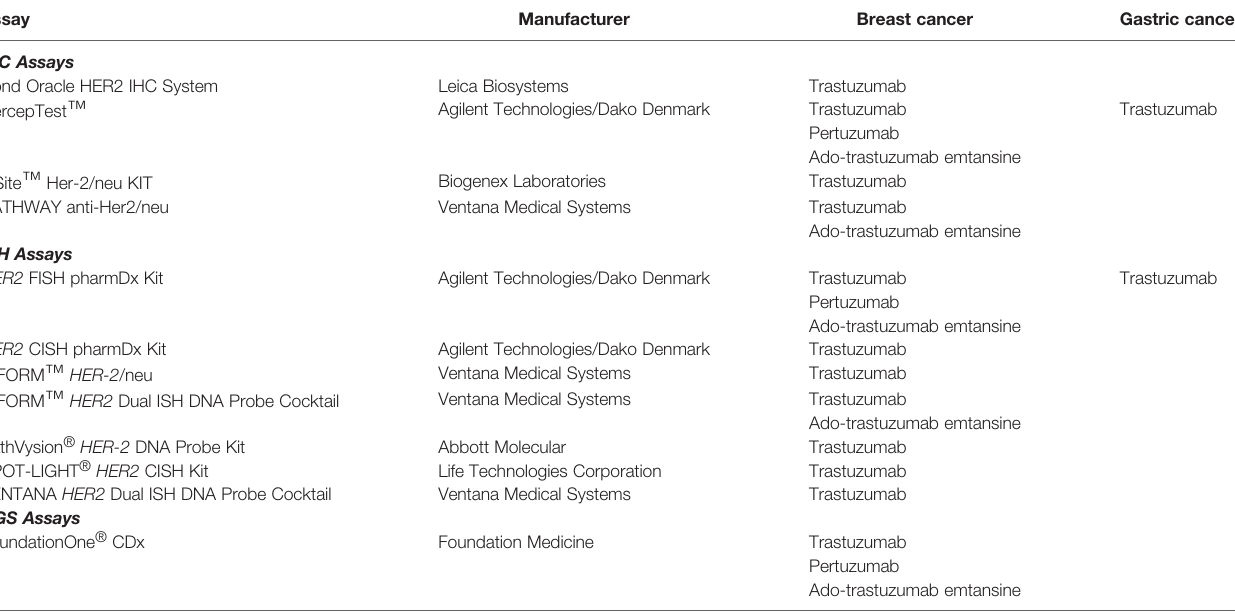
TABLE 3 | FDA approved companion diagnostics assays for HER2 targeted drugs. Not all the listed assays are currently available from the diagnostic manufactures